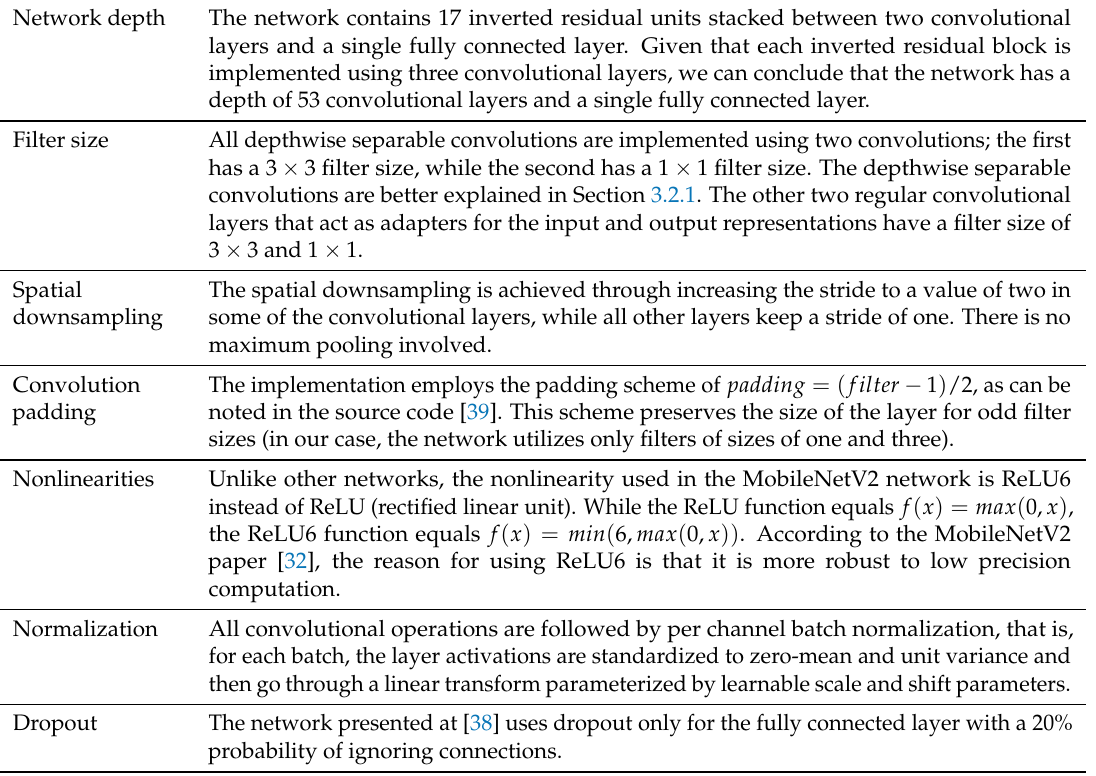
Table 2. Generic information related to the MobileNetV2 architecture [32]. In the details below, we took into account the implementation in